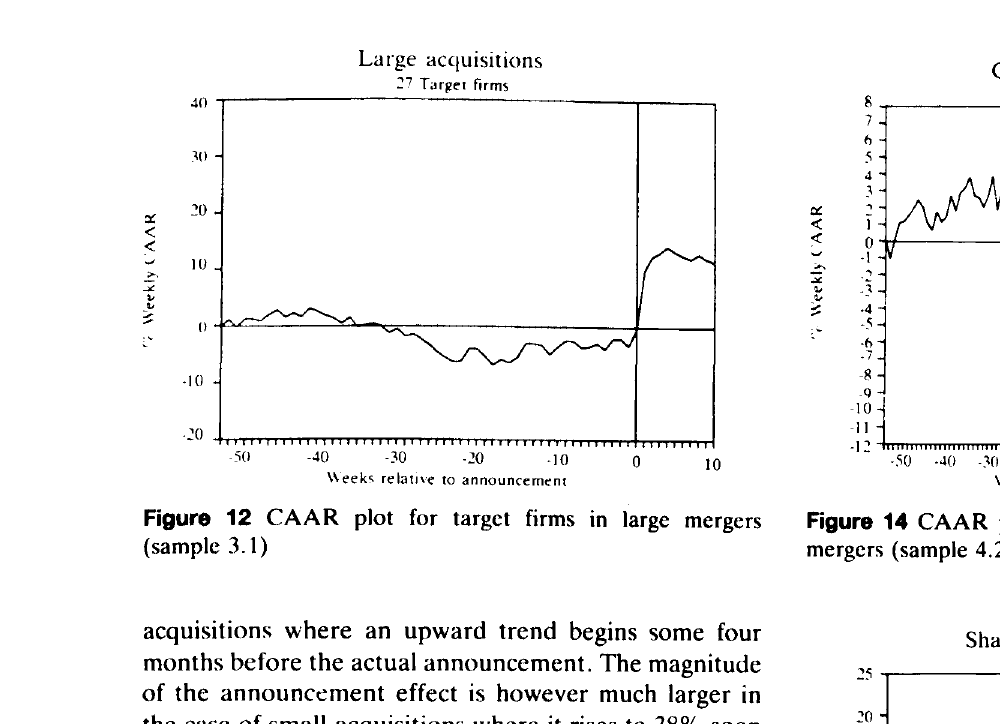
Figure 14 CAAR plot for acquiring firms in cash exchange mergers (sample 4.2)